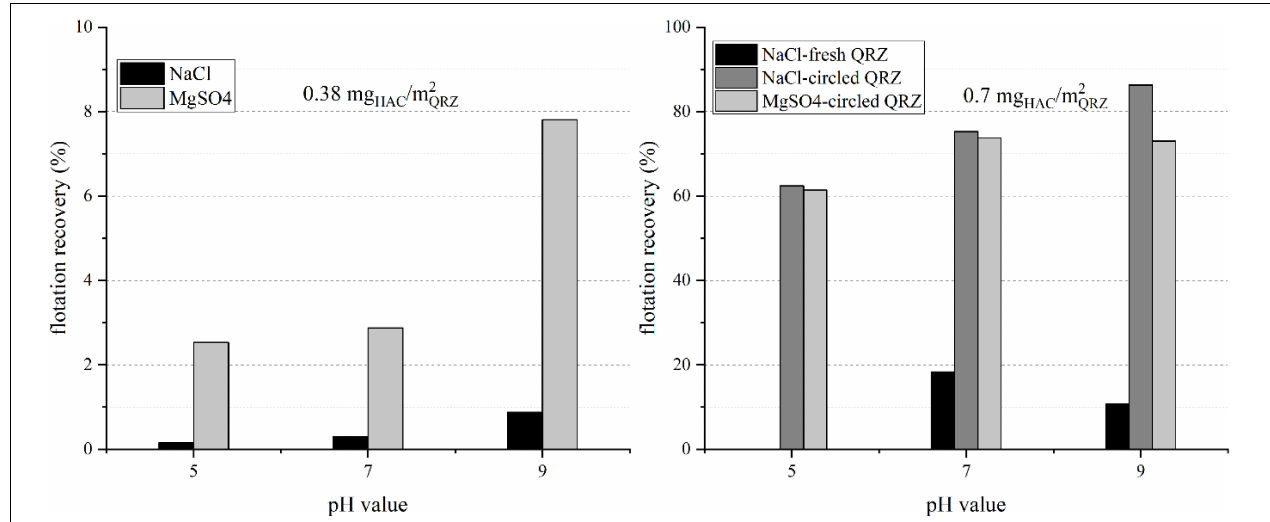
FIGURE 4 | The flotation recovery of quartz using hexyl-amine nanocrystals as collector with a concentration of 0.38 mg HAC /m 2 QRZ (left) and 0.7 mg HAC /m 2 QRZ (right) in different background salt solutions (shown is the mean value of two experiments).